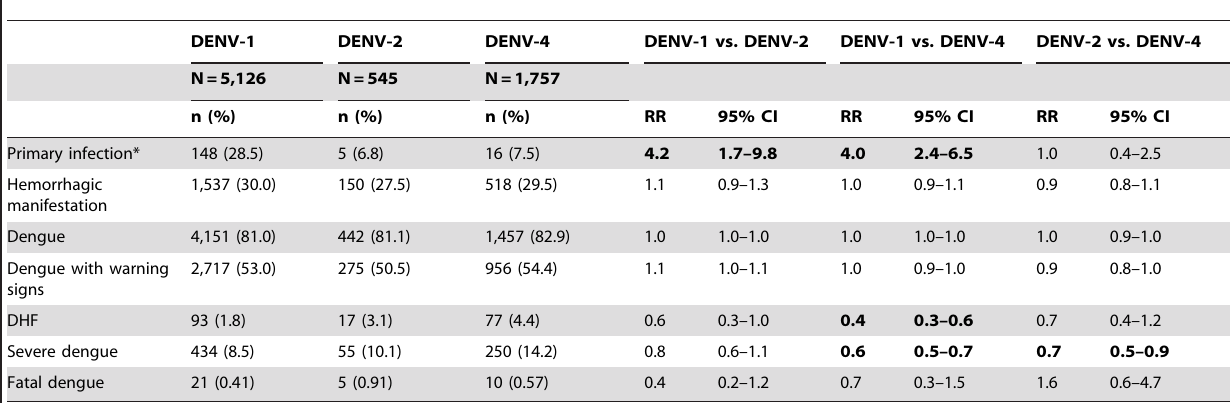
Table 2. Clinical characteristics of laboratory-positive cases by infecting dengue virus (DENV)-type, Puerto Rico, 2010.